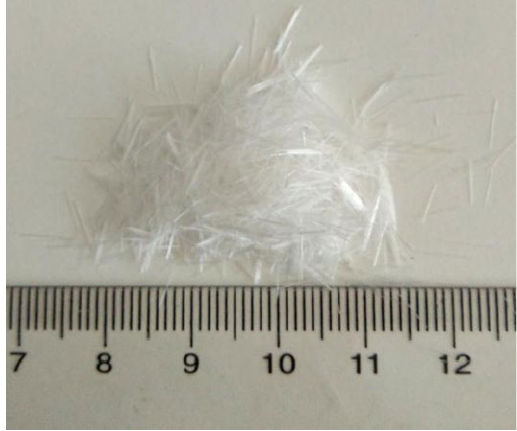
Figure 1. Polypropylene fibers.